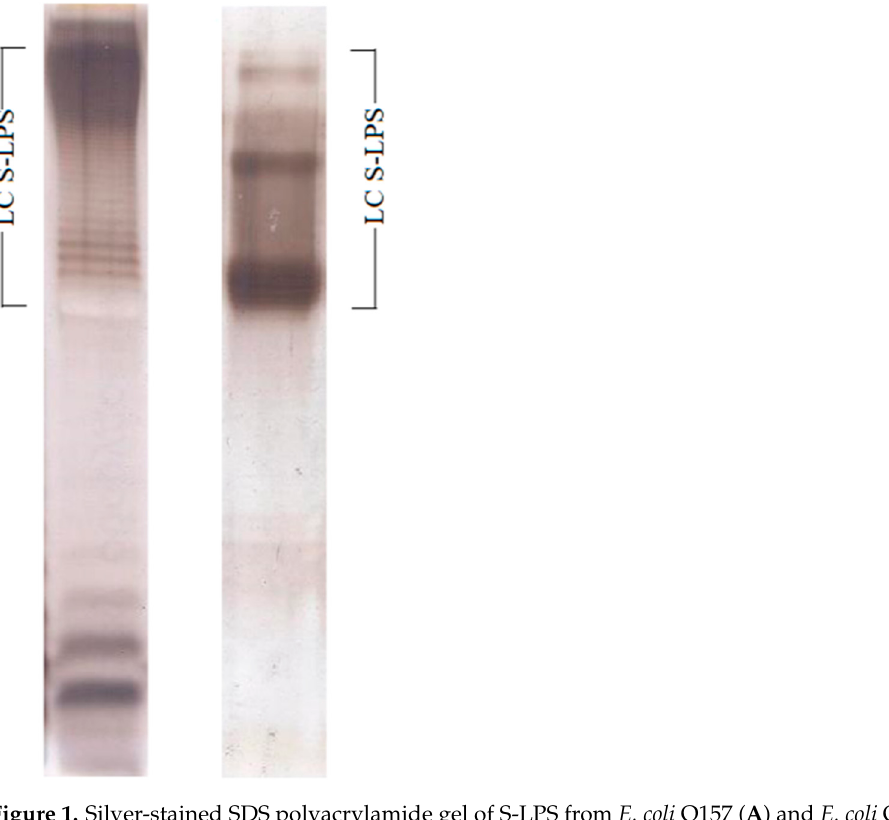
Figure 1. Silver-stained SDS polyacrylamide gel of S-LPS from E. coli O157 ( A ) and E. coli O104 ( B ). LC S-LPS indicate S-LPS with long-chain O-polysaccharide.